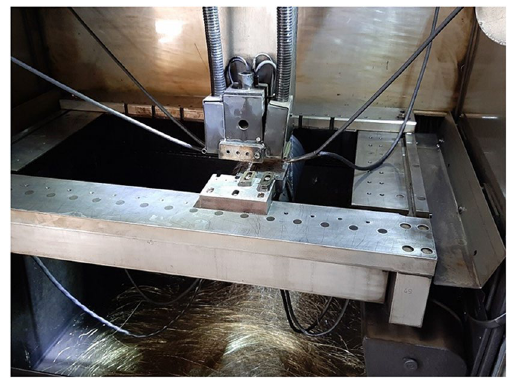
Fig. 3 Charmilles Robofil 310F wire-cut EDM machine, 1994, Poland, CNC type, Axis shift in X-Direction: 400 mm, Axis shift in Y-Direction: 250 mm, Z-axis travel: 400 mm, Stroke of the U axis: 400 mm, Stroke of the V-axis: 250 mm, taper capacity: 0.1 to 0.3 mm